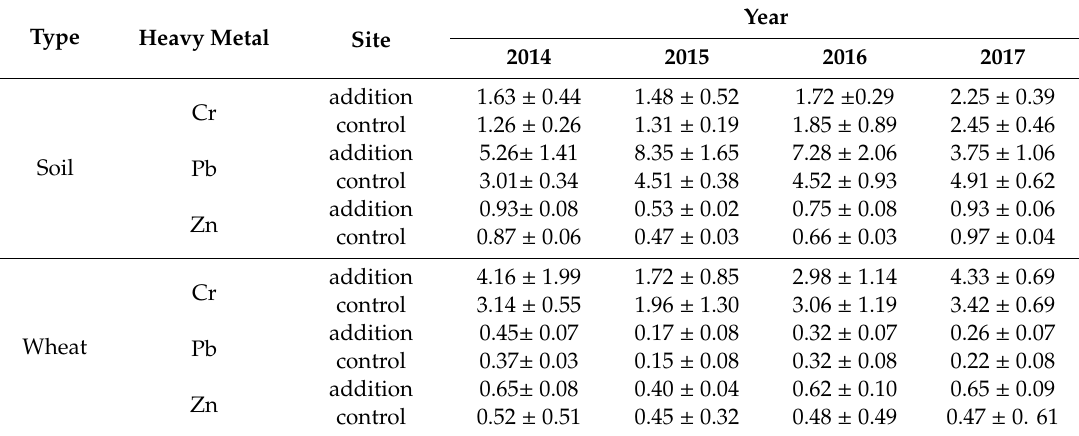
Table 3. Mean and standard deviation (SD) (mean ± SD) of risk indices of Cr, Zn and Pb in soil and